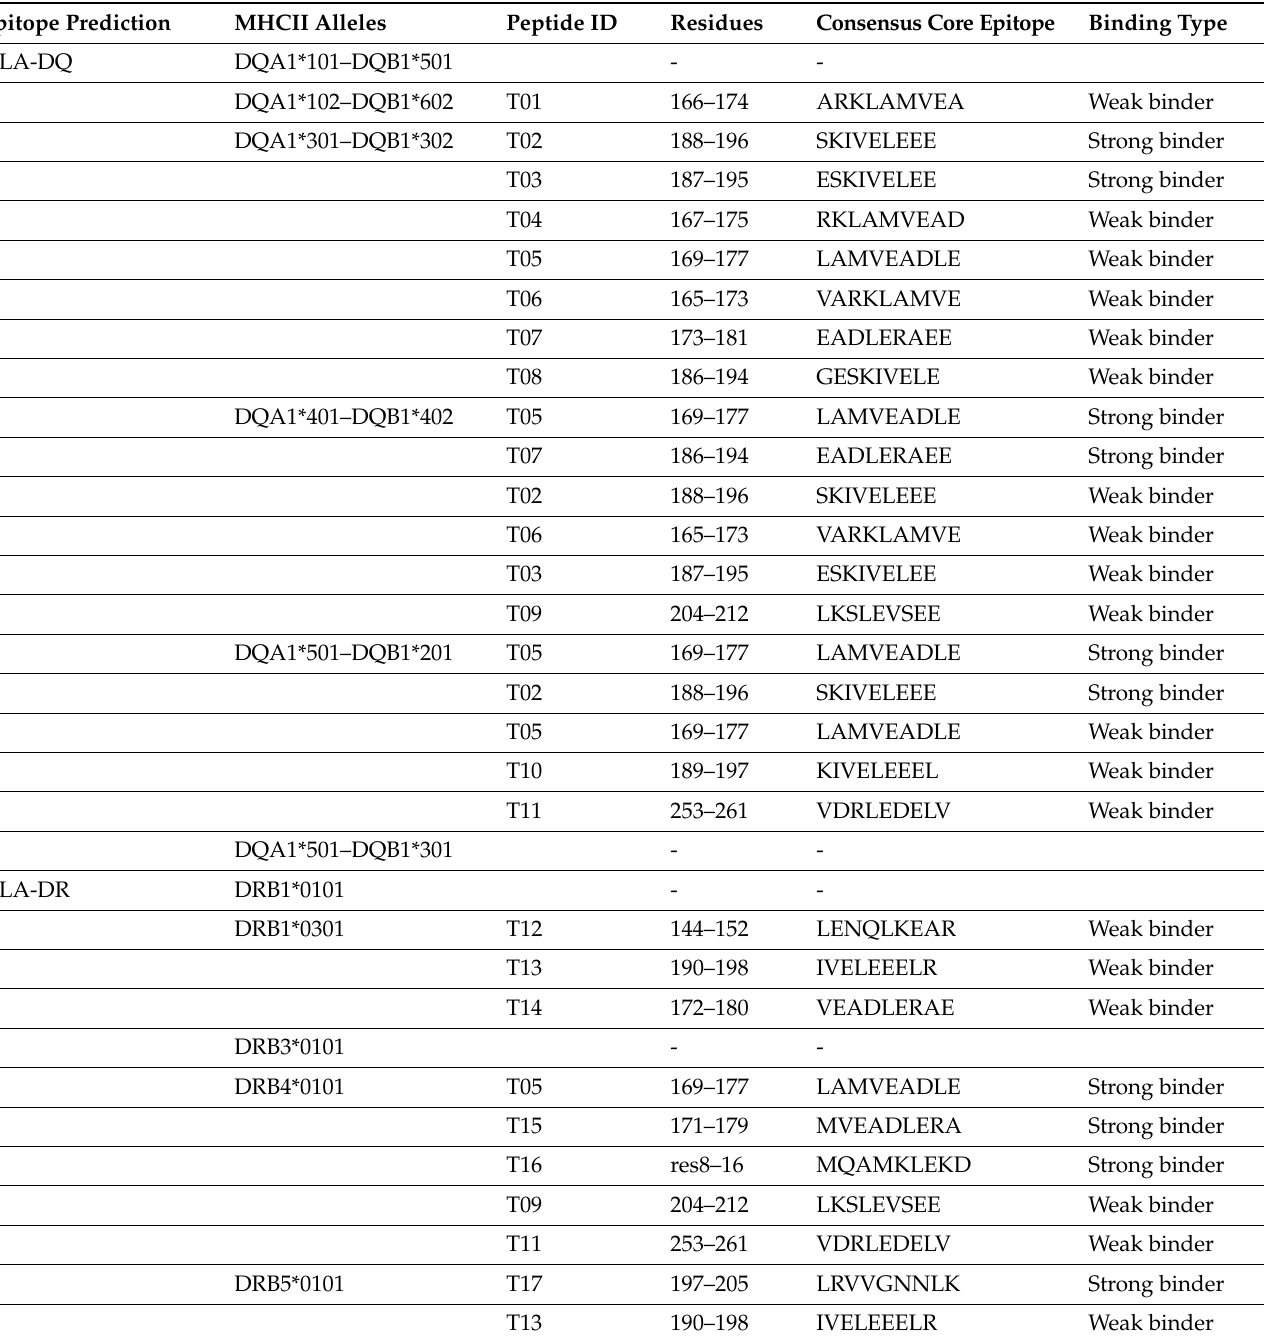
Table 3. Predicted linear T cell